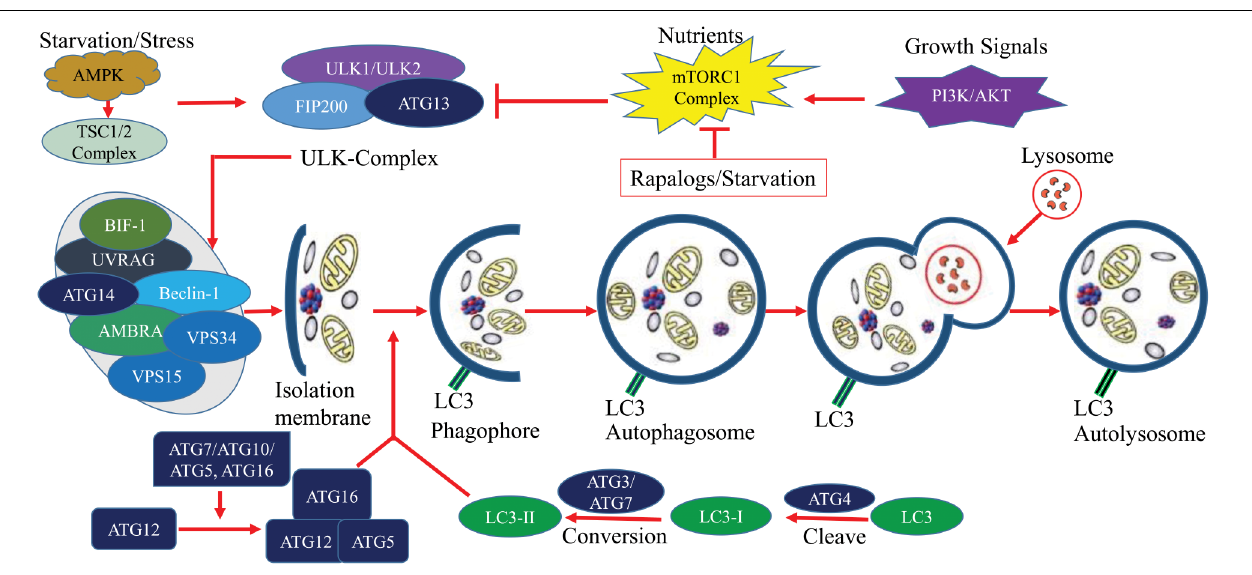
FIGURE 2 | The molecular signaling of the autophagy process. Autophagy is a critical process of cells, it can be simplified into several steps including, Formation of isolation membrane; Nucleation of phagophore; Maturation into autophagosome and Autolysosome. Under starvation/stress, ATP/AMP activates AMPK which further activates TSC1/2 complex. This complex induces autophagy through the blocking of mTOR. Elongation is controlled by ATG7 and ATG10 mediated covalent conjugation with ATG12 and ATG5. ATG5/ATG12 non-covalently bind with ATG16 to form an ATG12/ATG5/ATG16 complex which subsequently adds LC3 to phagophoric barrier. Circular autophagosome formation is carried out by recycling of LC3 (conversion of LC3I to LC3II by ATG4). Mature autophagosome gradually fuses with lysosome for selective degradation and recycling of nutrients. This figure was based on published data (Kim and Lee, 2014; Cicchini et al., 2015; Ktistakis and Tooze,